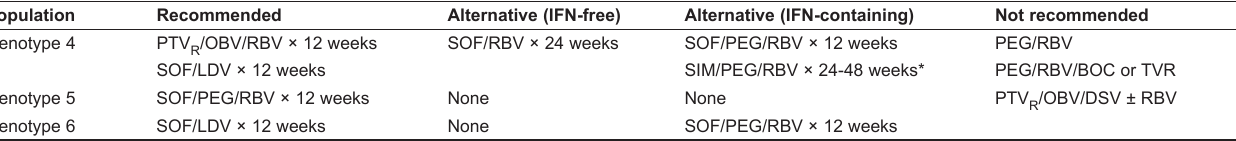
TABle 8 Patients with hepatitis C virus (HCV) genotypes 4, 5 and